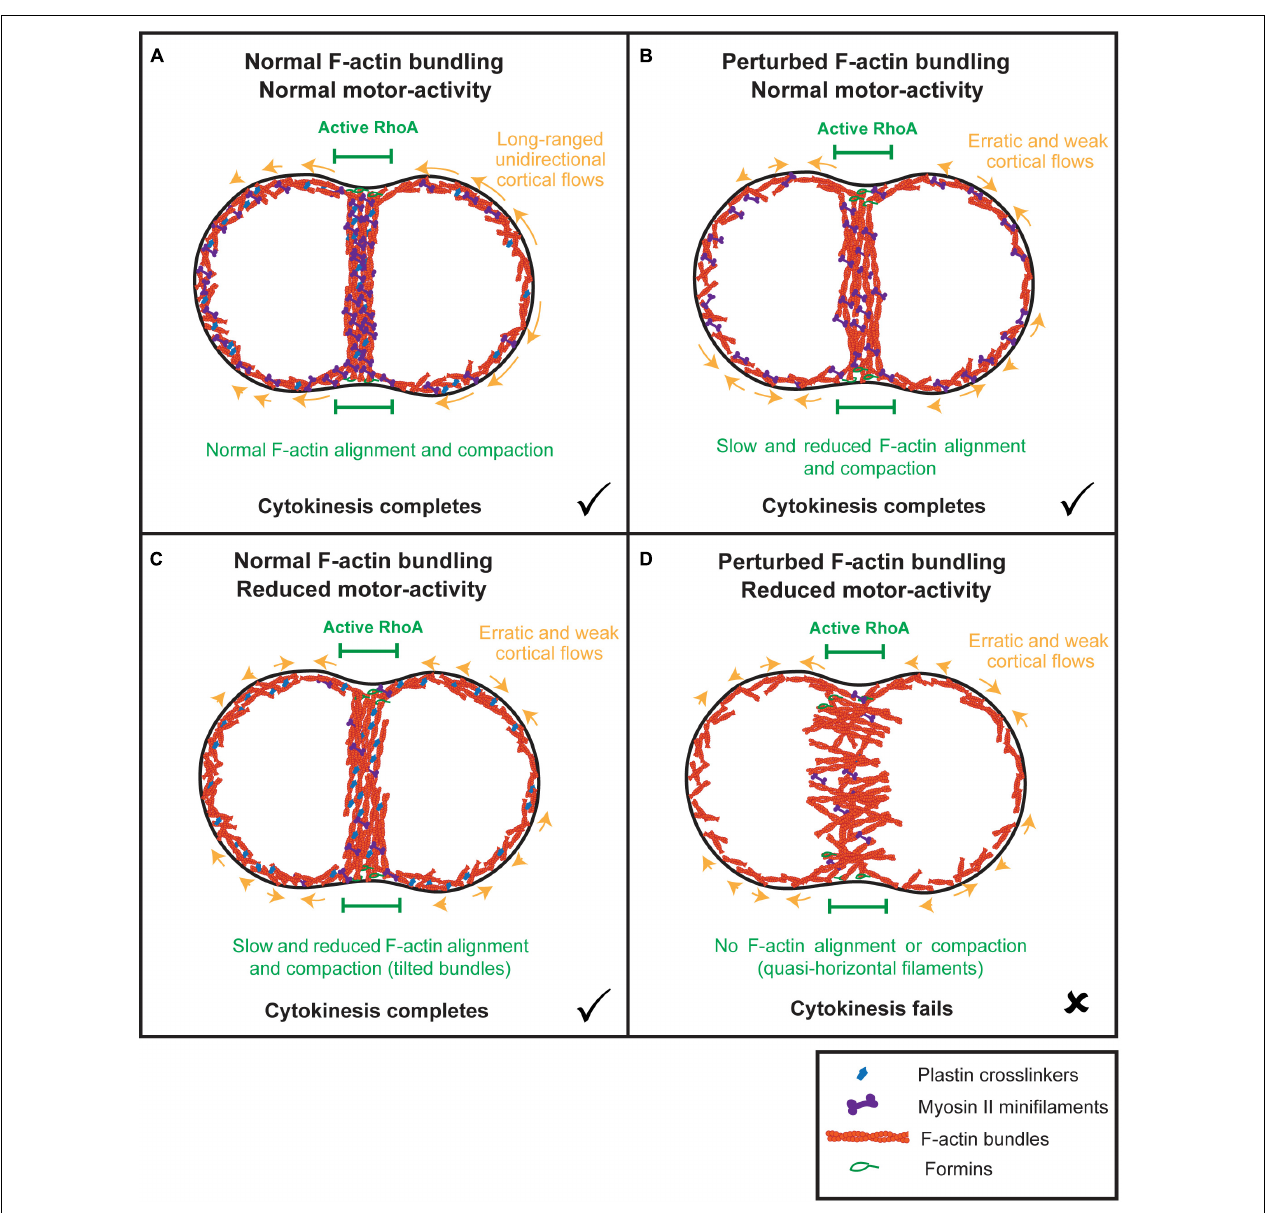
FIGURE 5 | Model: the combined synergistic action of plastin and myosin aligns and compacts F-actin at the division plane independently of actomyosin cortical flows. (A) When both plastin and myosin accumulate at the equator, F-actin bundles are properly connected, and myosin is able to efficiently align and compact them into a circumferential array to maximize tension. Early actomyosin flows are unidirectional and long-ranged. (B) In the absence of plastin-mediated bundling, myosin struggles to align and compact F-actin bundles, initially spending energy on filament sorting instead of filament sliding. Cortical flows are reduced and erratic and cytokinesis completes with delays in F-actin alignment and contractile ring formation. (C) In the presence of plastin-mediated F-actin bundling and decreased myosin levels, F-actin bundles are connected to each other but tilt and struggle to orient along the division plane and to compact because of insufficient motor-activity. Cortical flows are severely reduced and erratic and cytokinesis completes with delays in F-actin alignment and contractile ring formation. (D) When both plastin-mediated bundling and myosin levels are decreased, equatorial actin filaments become unstable and start rotating and oscillating, adopting a quasi-horizontal orientation. Cortical flows are reduced and erratic, as in the individual plastin and myosin perturbations. F-actin bundles never align to form the contractile ring and cytokinesis